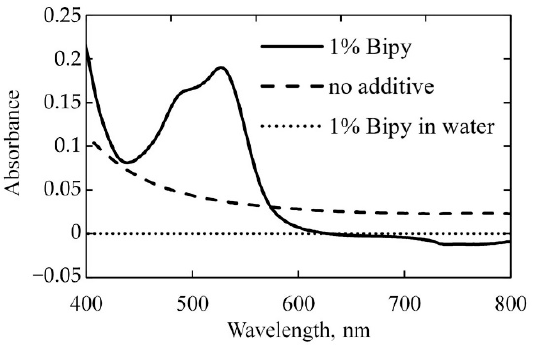
Figure 2. Absorption spectrum of 1% w/w Bipy in 90% w/w aqueous HAN compared to no addi-